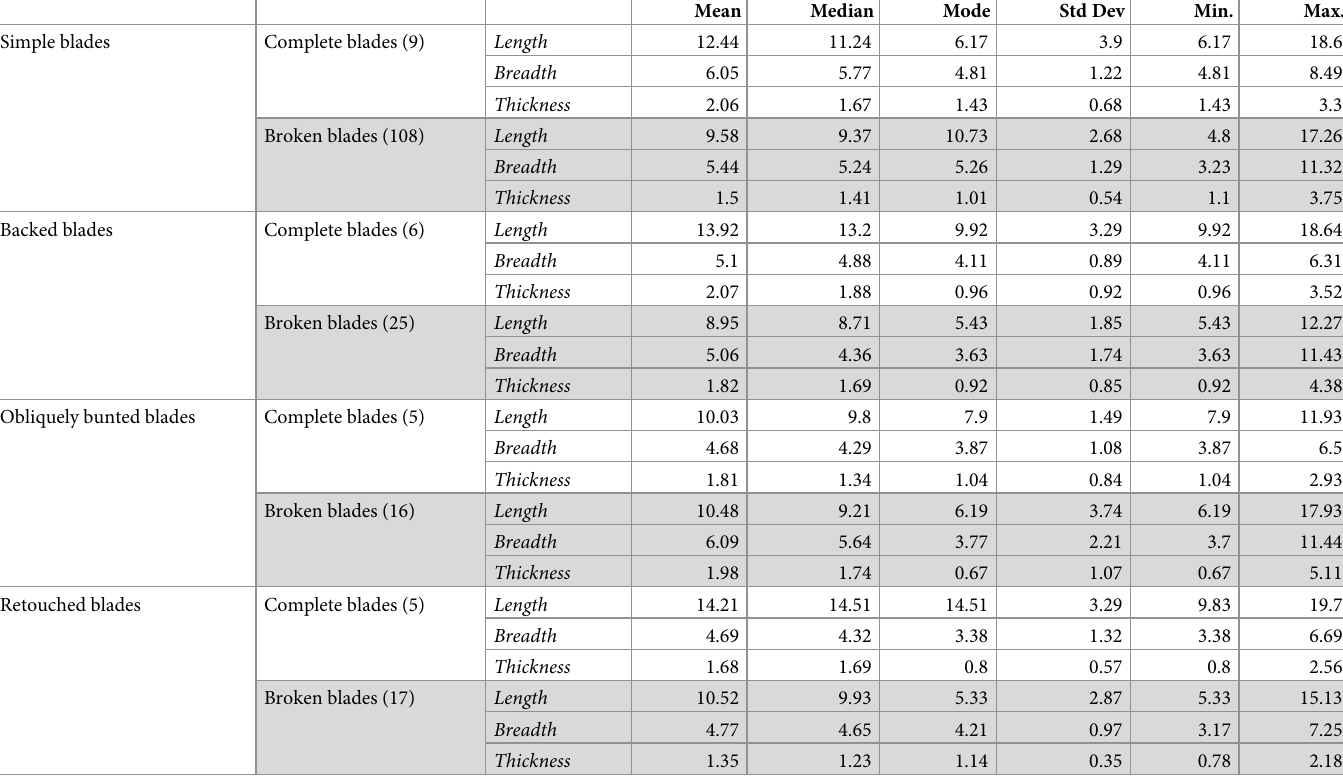
Table 1. Summarised metric data (in mm) of the blades from Vaharvo